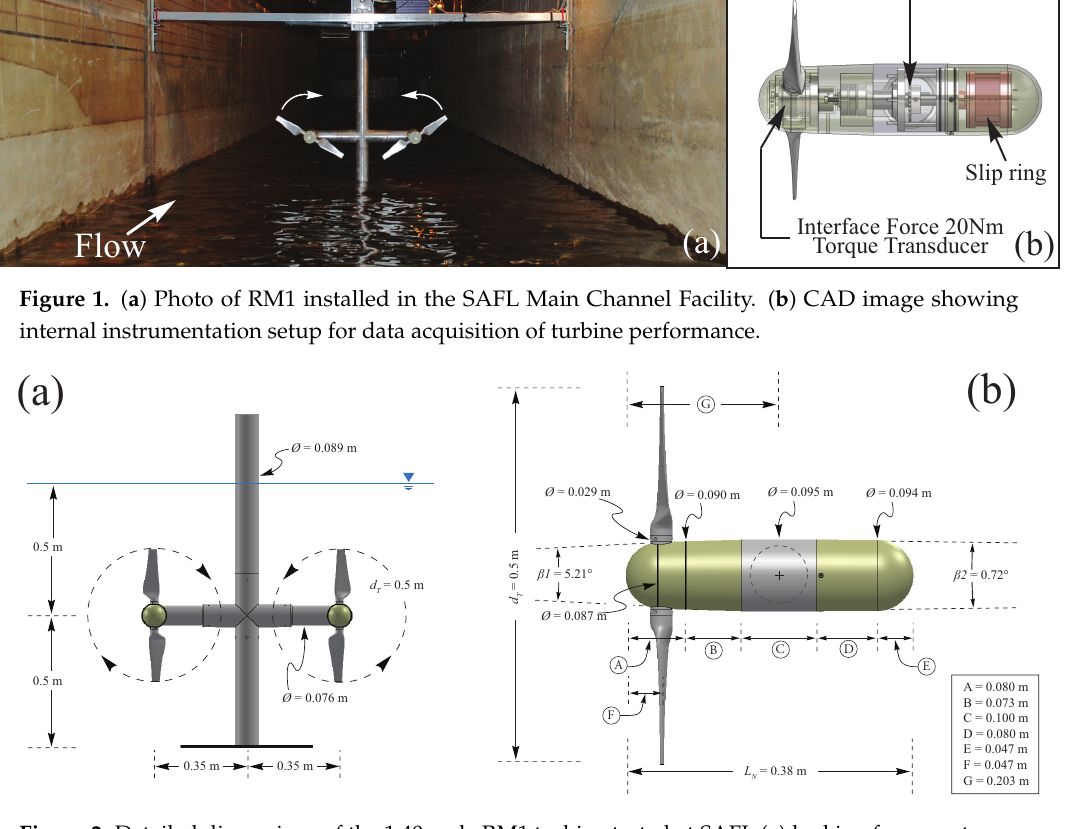
Figure 2. Detailed dimensions of the 1:40 scale RM1 turbine tested at SAFL ( a ) looking from upstream towards the turbine and ( b ) side view of the rotor and nacelle. CAD files for RM1 are available through the Tethys Engineering Signature Project